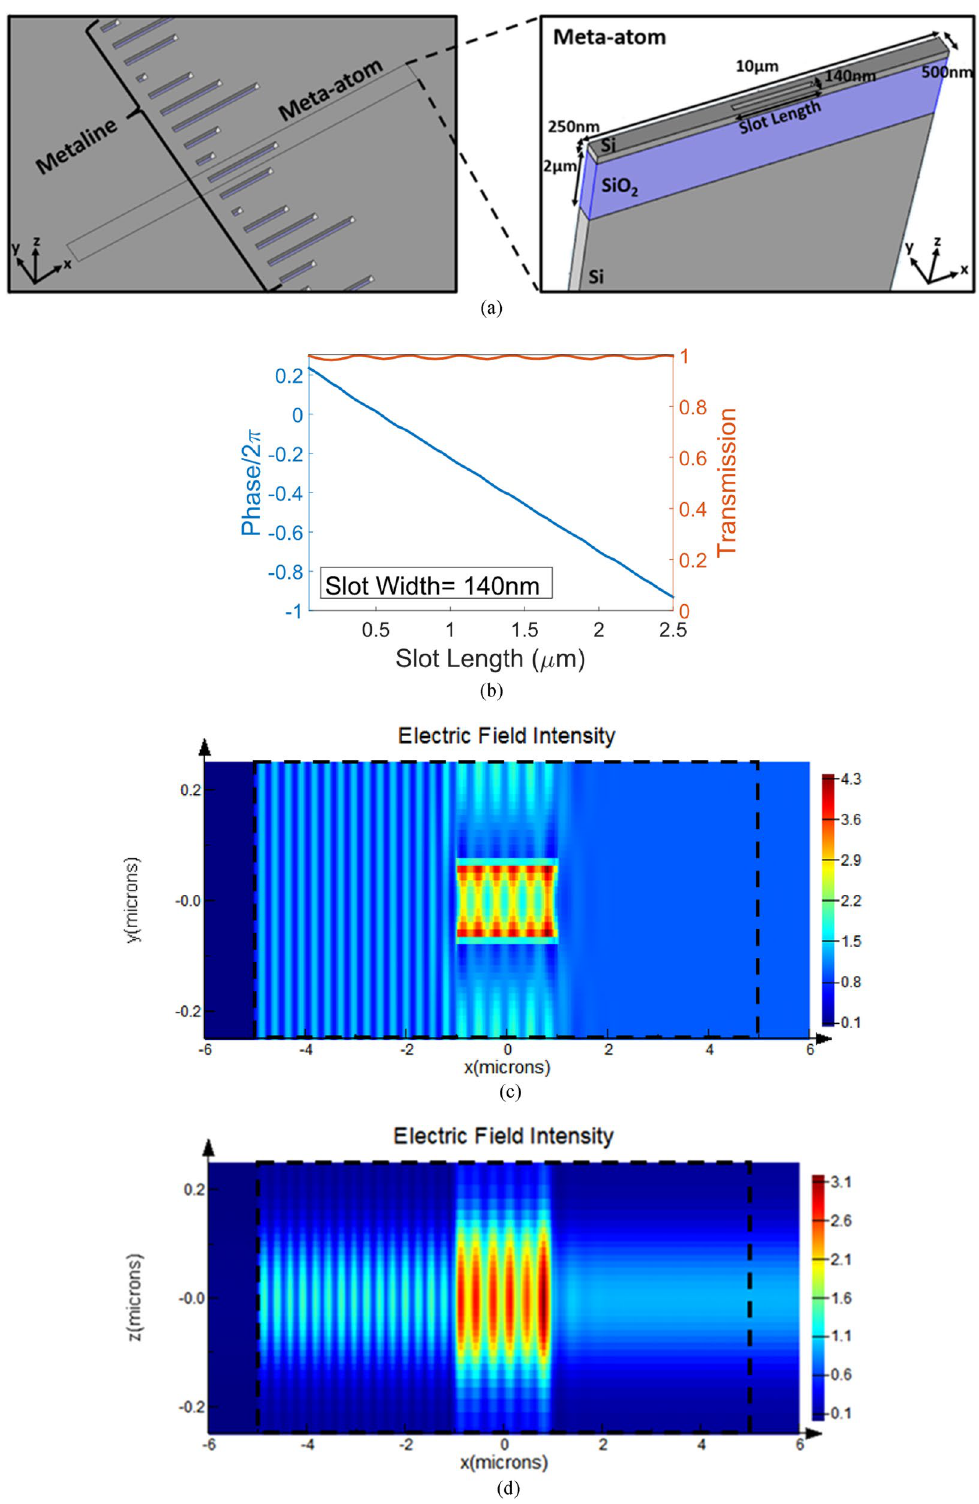
Figure 2. ( a ) Schematic of a metaline and a meta-atom consisting of a subwavelength slot which the length of the slot is a learnable parameter, ( b ) by changing the slot length between 100 nm and 2.3 µm, while keeping the slot width and height constantly as 140 nm and 250 nm, the transmission phase can be continuously tuned in the 0-to-2π range, while the transmission amplitude is higher than 0.96, ( c ) x–y view of the electric field intensity in a meta-atom with a 2 µm-length slot across the middle plane of the silicon slab (z = 0), ( d ) x–z view of the electric field intensity in a meta-atom with a 2 µm-length slot across the middle plane of the slot (y =